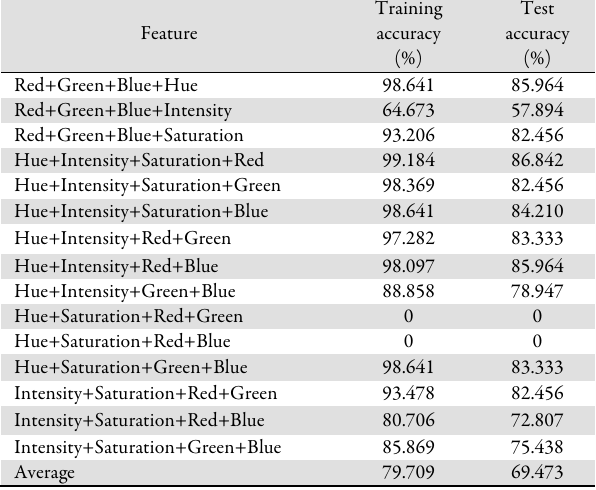
Table 5. Accuracy values using four colour features